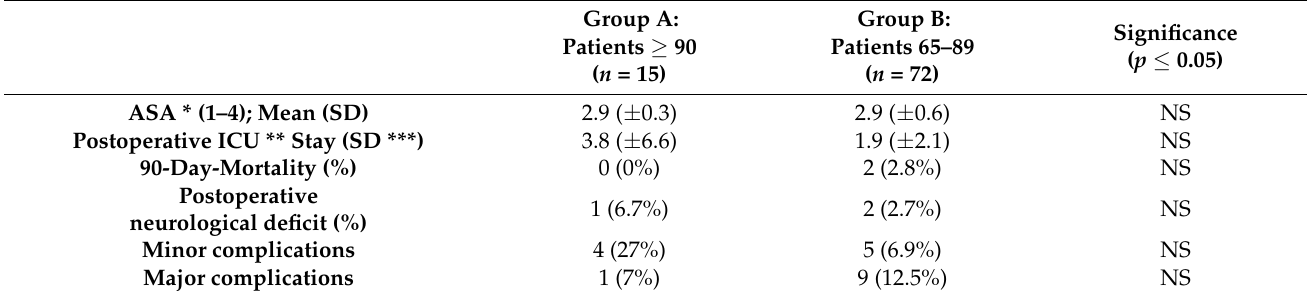
Table 5. Comparison of perioperative course and complication rates in patients over 90 years (Group A) to a retrospective analysis of patients between 65 and 89 years of age (Group